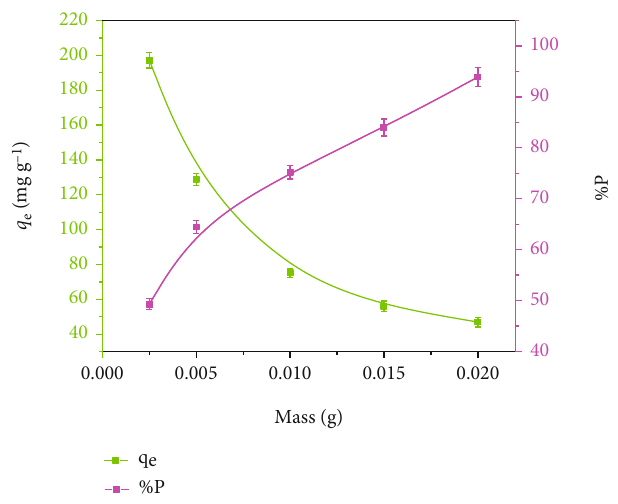
Figure 8: In fl uence of AgNP-SB- β CD dosage on uptake of BPA at 25 ° C.